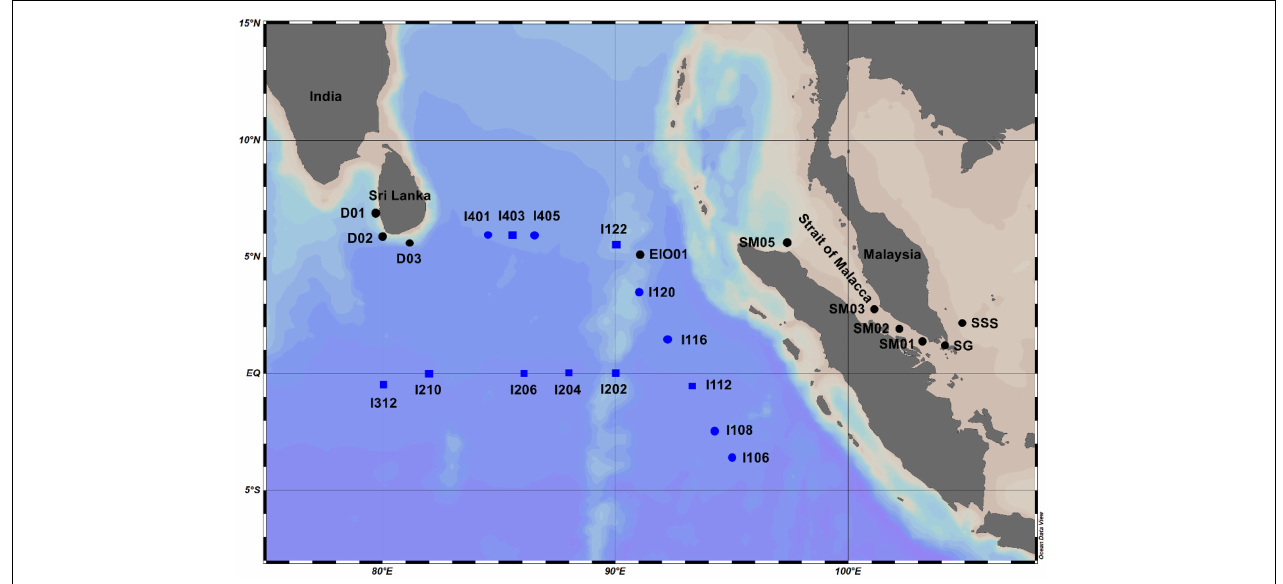
FIGURE 1 | Sampling stations in the eastern Indian Ocean (EIO), coastal waters of Sri Lanka, and the Strait of Malacca. Black dot–labeled stations: samples were collected from surface water in 2018; blue dot–labeled stations: samples were collected from surface water in 2015; blue square–labeled stations: samples were collected from water column (surface: 25, 75, and 150 m) in